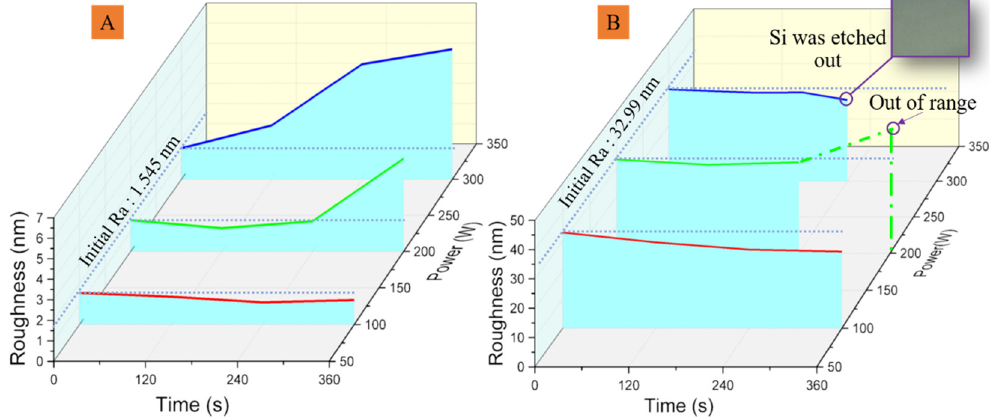
Figure 4. Surface roughness for different oxygen plasma treatment measured with AFM, ( A ) sput- tering Cu and ( B ) electroplating Cu.